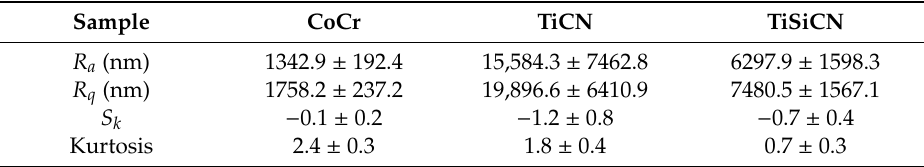
Table 6. Main roughness parameters of the investigated specimens after corrosion tests.